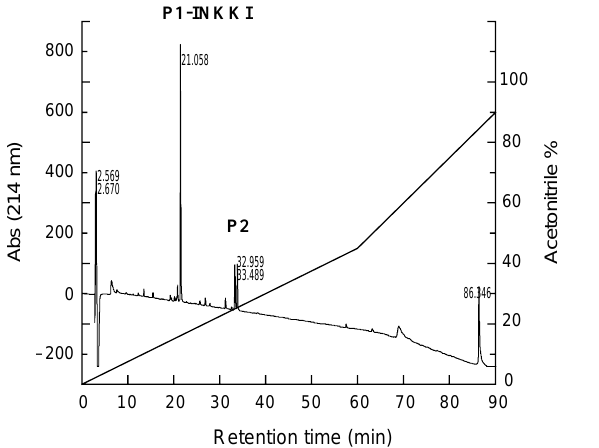
FIG. 2. HPLC chromatography of pool III obtained from Sephadex G-10 chromatography in a C 18 analytical reversed-phase column eluted with a linear gradient of acetonitritrile 0 (cid:2) / 45% in 45 min and 45 (cid:2) / 90% acetonitrile in 45 (cid:2) / 70 min in TFA 0.1% (in water), flow rate of 1 ml/min monitored at 214 nm.